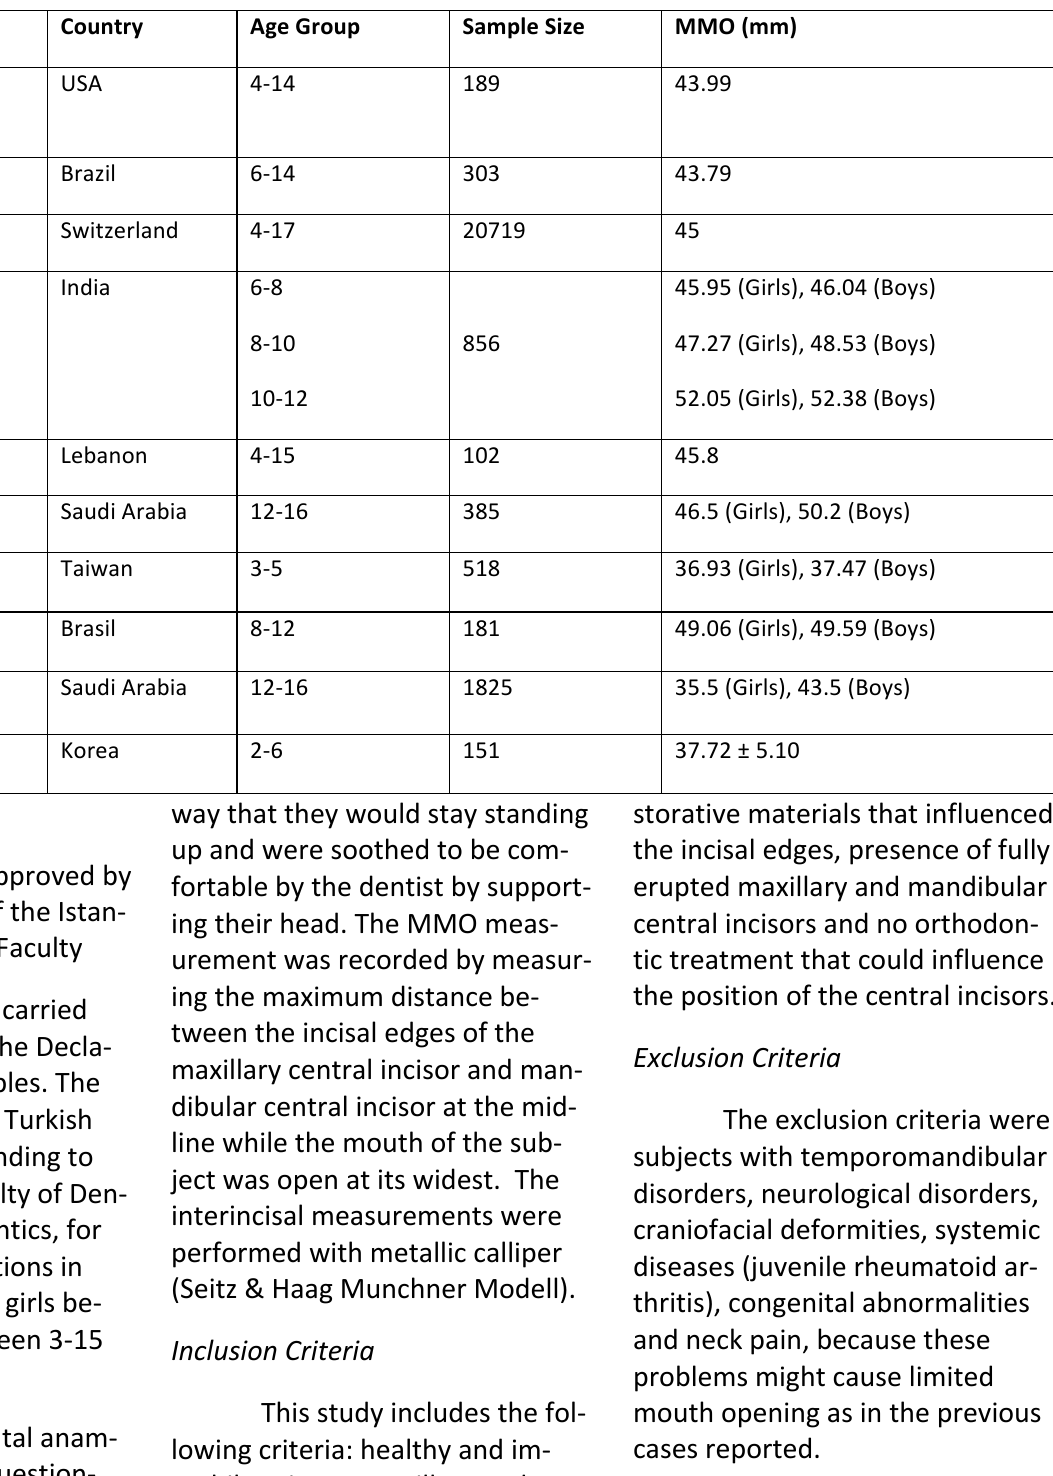
Table 1. Children and adolescent MMO values from different s tudies